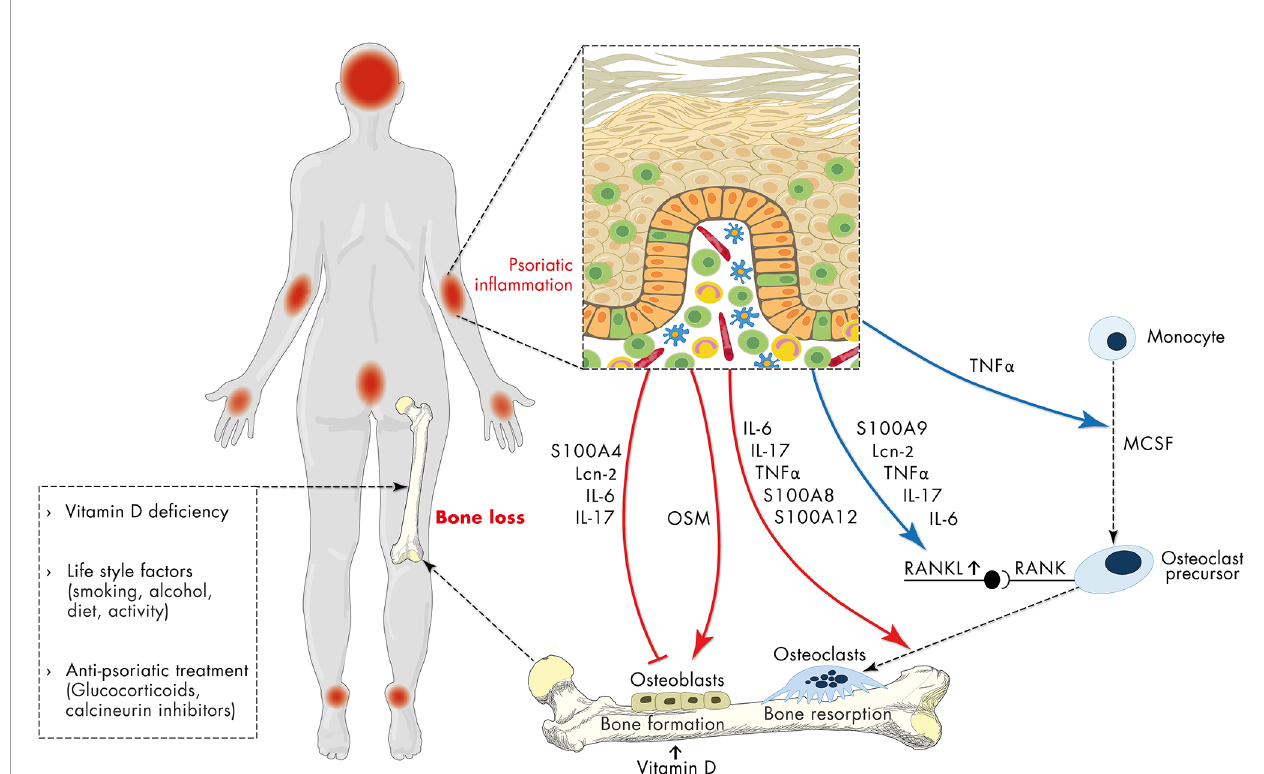
FIGURE 2 | Schematic representation of the relationship of psoriasis and osteoporosis. Apart from vitamin de fi ciency, life-style factors and anti-psoriatic treatment with e.g., glucocorticoids, the sustained and uncontrolled in fl ammatory response in psoriasis has a negative impact on bone metabolism contributing to osteoporosis. Psoriasis-associated factors including antimicrobial peptides (S100 proteins, lipocalin 2 (Lcn2)), IL-6, IL-17 directly inhibit osteoblast differentiation, while oncostatin M (OSM) promotes it. On the other hand, psoriasis-associated factors directly support RANKL-induced osteoclast differentiation and indirectly promote osteoclast differentiation by stimulation of RANKL expression. In addition, sustained expression of pro-in fl ammatory mediators, antimicrobial peptides and chemokines initiates a vicious cycle of in fl ammation which in turn interferes with both osteoblast and osteoclast differentiation and may thereby connect chronic psoriatic in fl ammation to impaired bone